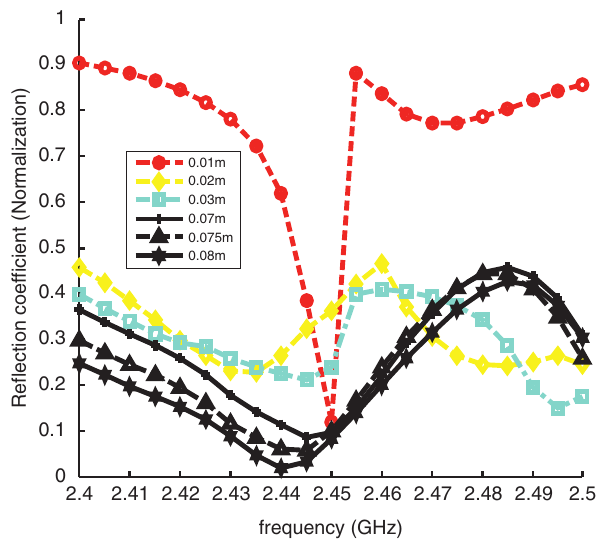
Figure 7: The mutual coupling between the frequencies and the thickness of titanium